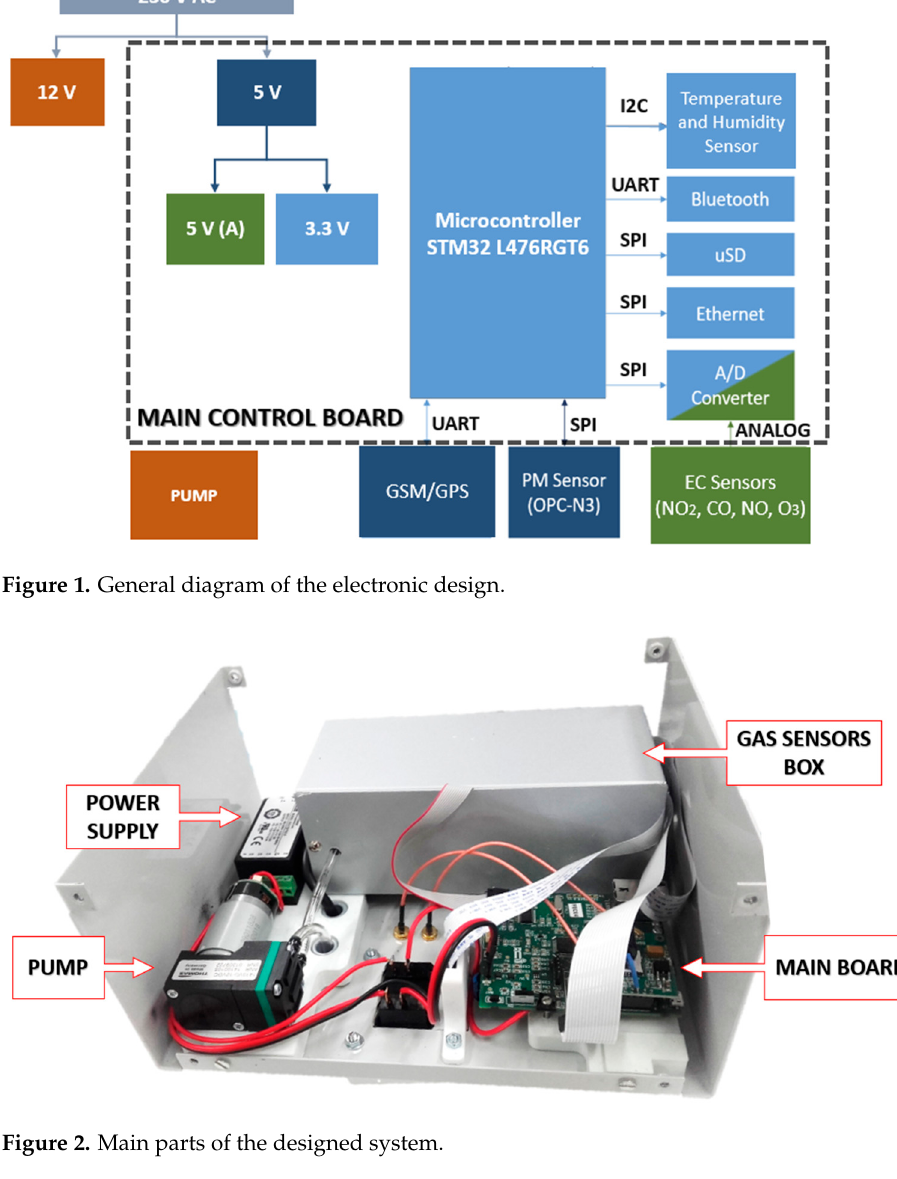
Figure 2. Main parts of the designed system.